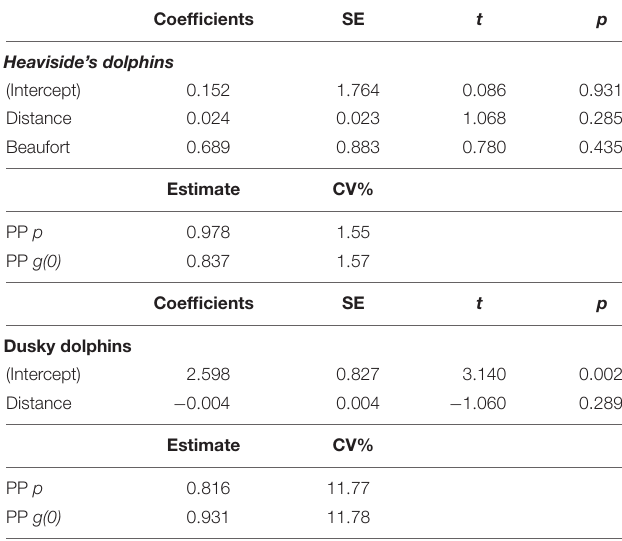
TABLE 2 | Summary of detections of Heaviside’s and dusky dolphin groups by each observer platform when on simultaneous effort. Stratum PP TP Duplicate